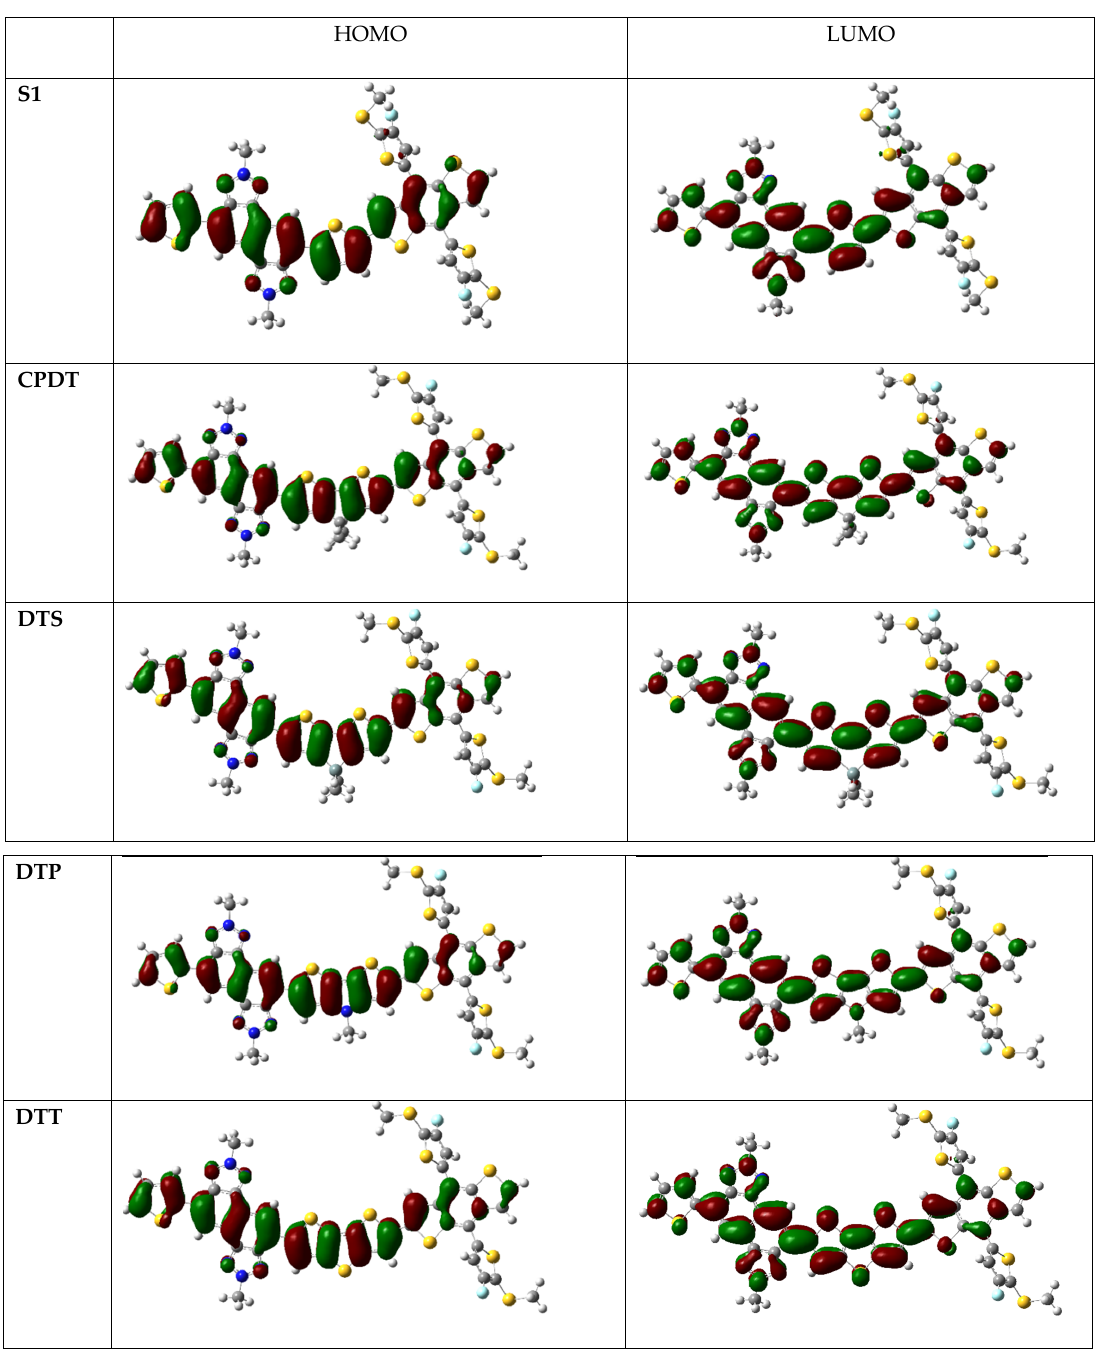
Figure 2. Spatial distributions of the frontier molecular orbitals of the compounds designed.